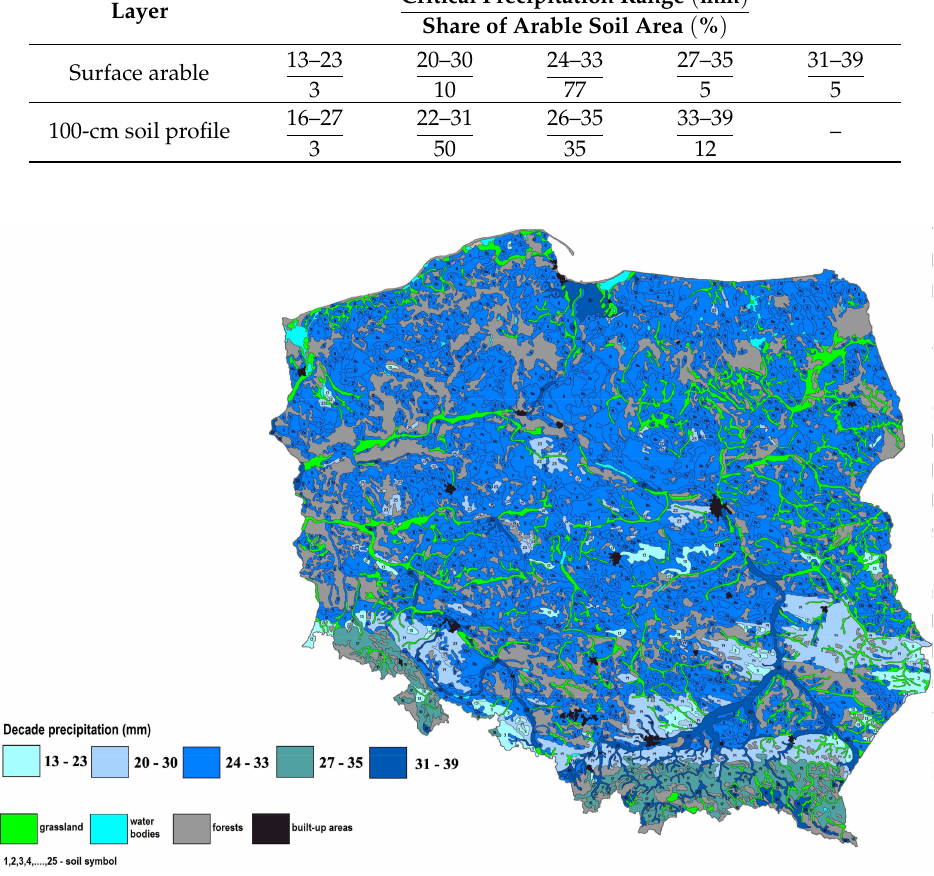
Figure 3. Map of the decade precipitation (mm) preventing readily available soil water depletion in the surface layer of arable soils in